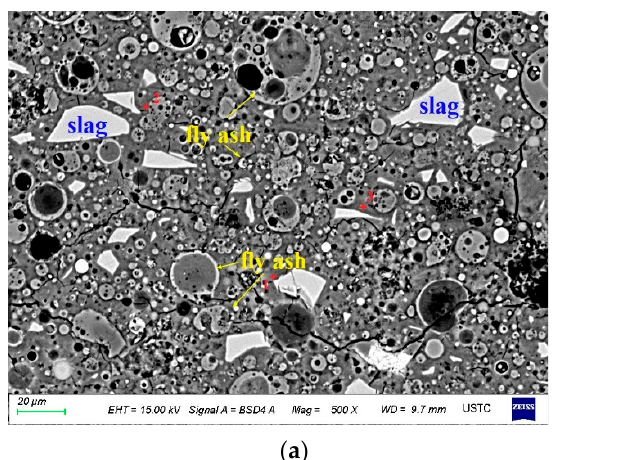
Figure 9. Porosity of AA–FASM under seal– and water–saturation–curing conditions.